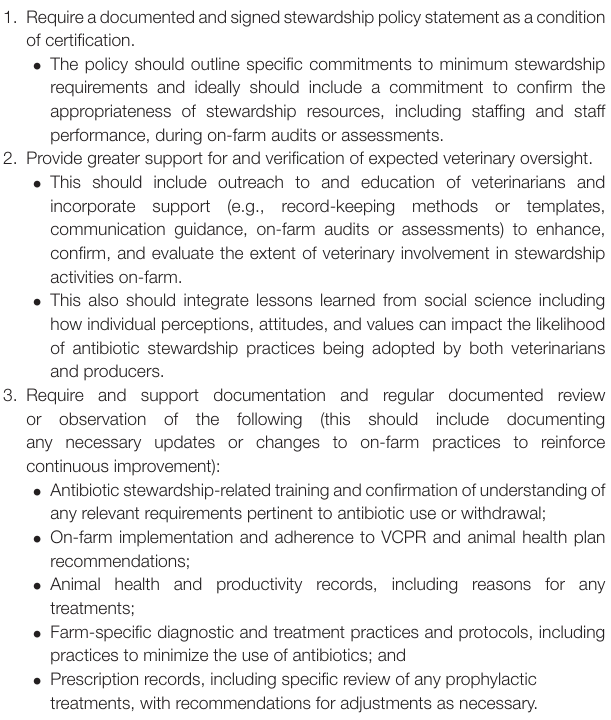
TABLE 5 | Recommendations to enhance existing certification